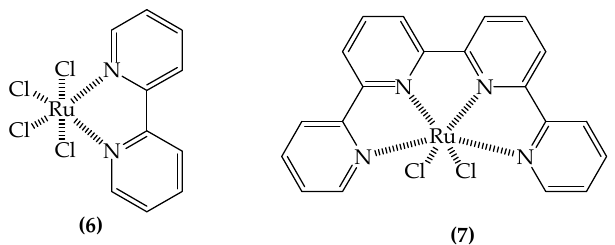
Figure 7. Chemical structure of bioactive Ru complexes ( 6 – 7 ) [133].